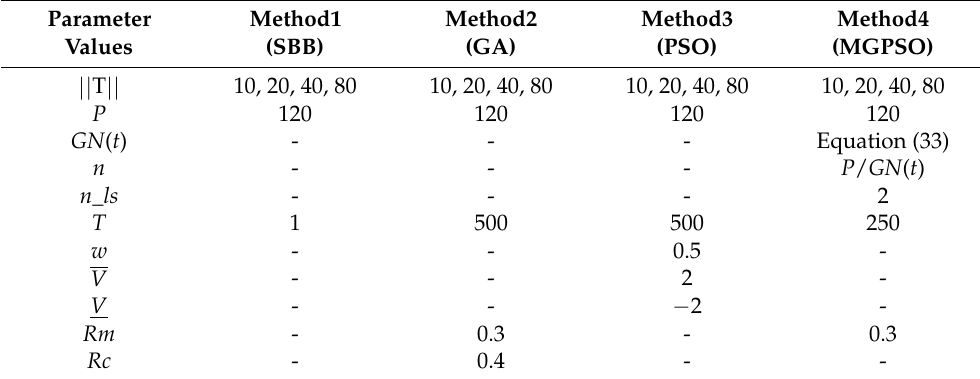
Table 3. The parameter setting for different